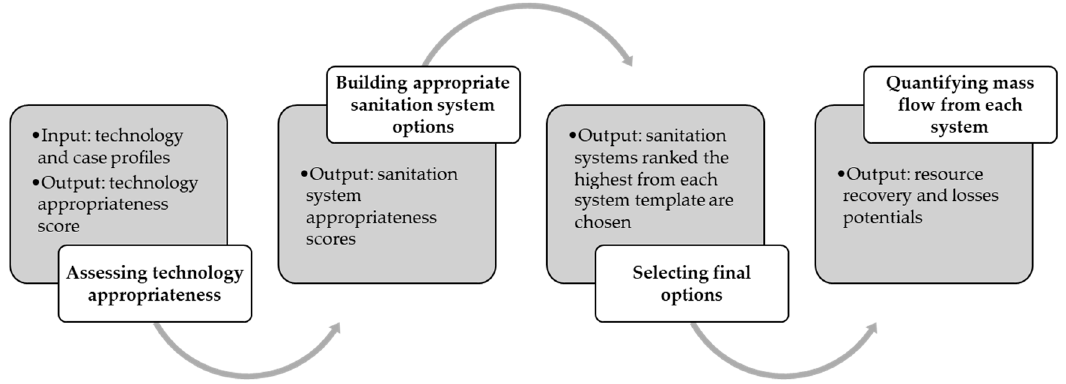
Figure 1. The Santiago procedure according to